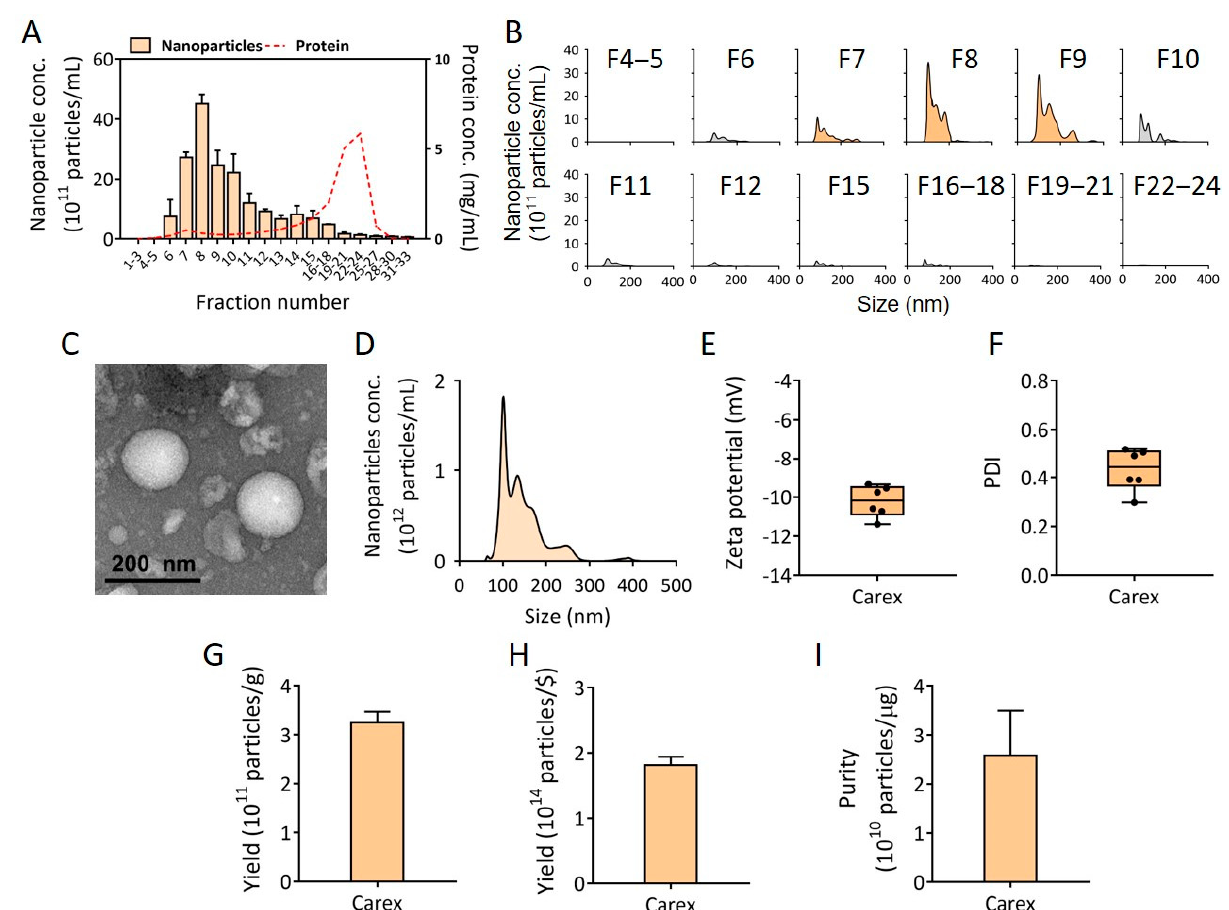
Figure 2. Isolation of nanovesicles from carrots and its characterization. ( A ) Carex was isolated and purified from carrots, using ultrafiltration followed by size-exclusion chromatography. The concentrations of nanovesicles and proteins in all size-exclusion chromatography fractions were assessed. ( B ) The size distribution of each fraction was shown. The nanovesicle-containing fractions (fraction 7–9) were used for further characterization. ( C ) The morphology of Carex was analyzed using TEM. ( D ) The representative size distribution of Carex was analyzed using NTA. ( E , F ) The zeta potential and PDI of Carex were analyzed using DLS. ( G – I ) Carex yield per g of carrot ( G ), yield per carrot price, and purity per μ g of protein impurities are shown.